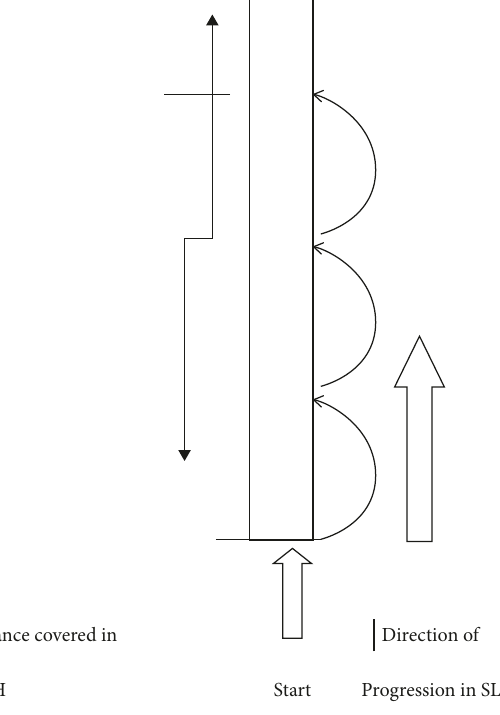
Figure 3: Illustration of single-leg triple hop (SLTH)